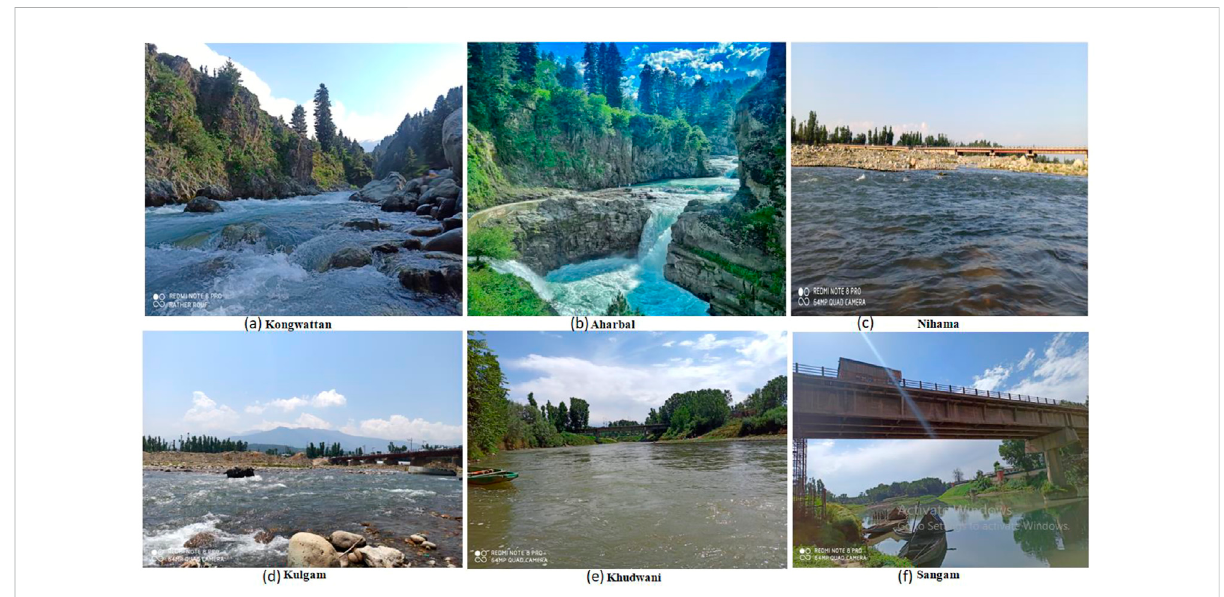
FIGURE 2 Sampling locations during collection of water samples from Veshaw river [ (A) :Kongwattan; (B) Aharbal; (C) :Nihama; (D) :Kulgam; (E) :Khudwani; (F)